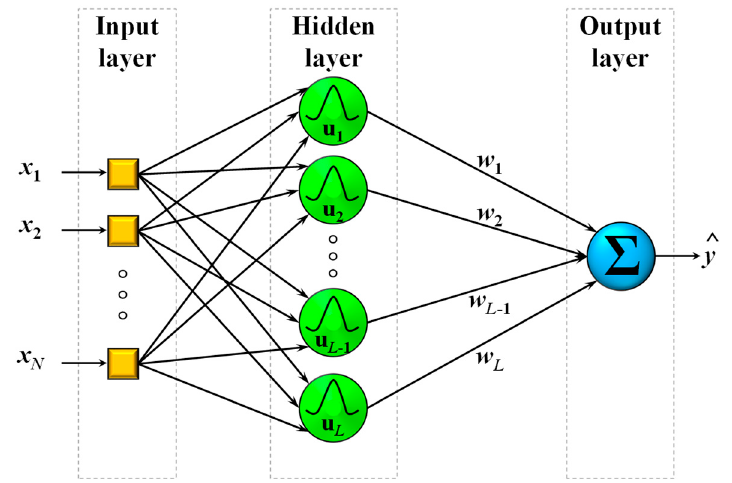
Figure 1. A typical radial basis function network structure using Gaussian RBFs.